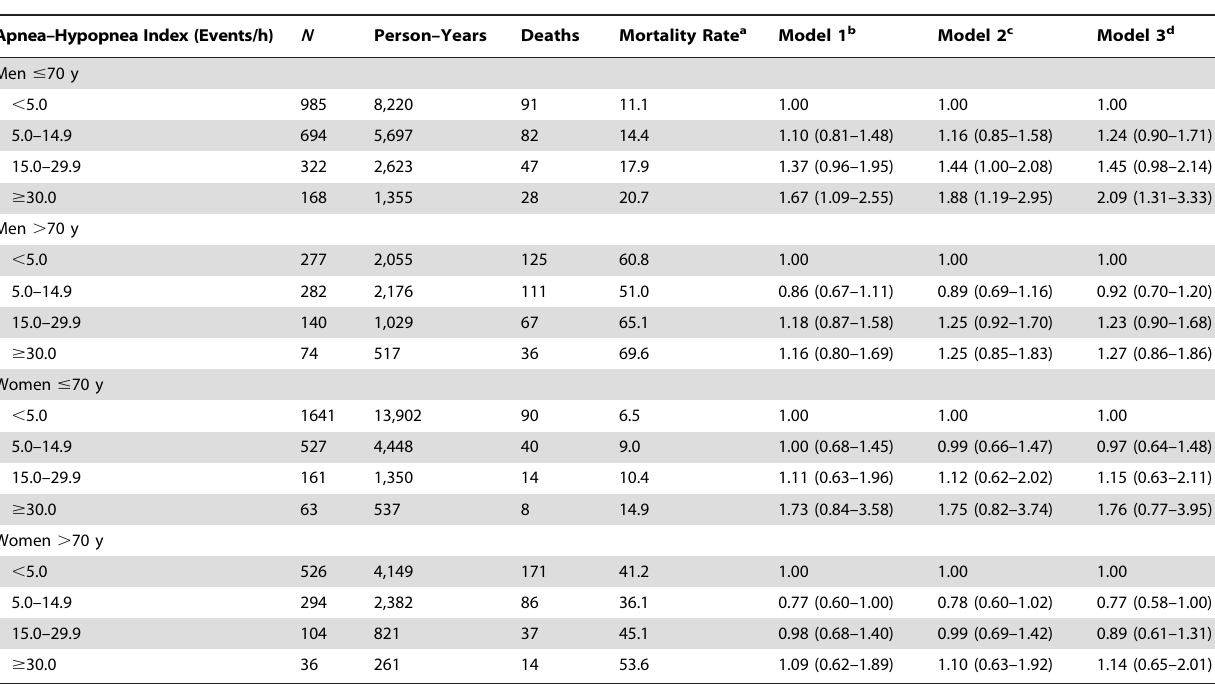
Table 3. Adjusted hazard ratios (95% confidence intervals) for all-cause mortality associated with sleep-disordered breathing,stratified by sex and age in the Sleep Heart Health